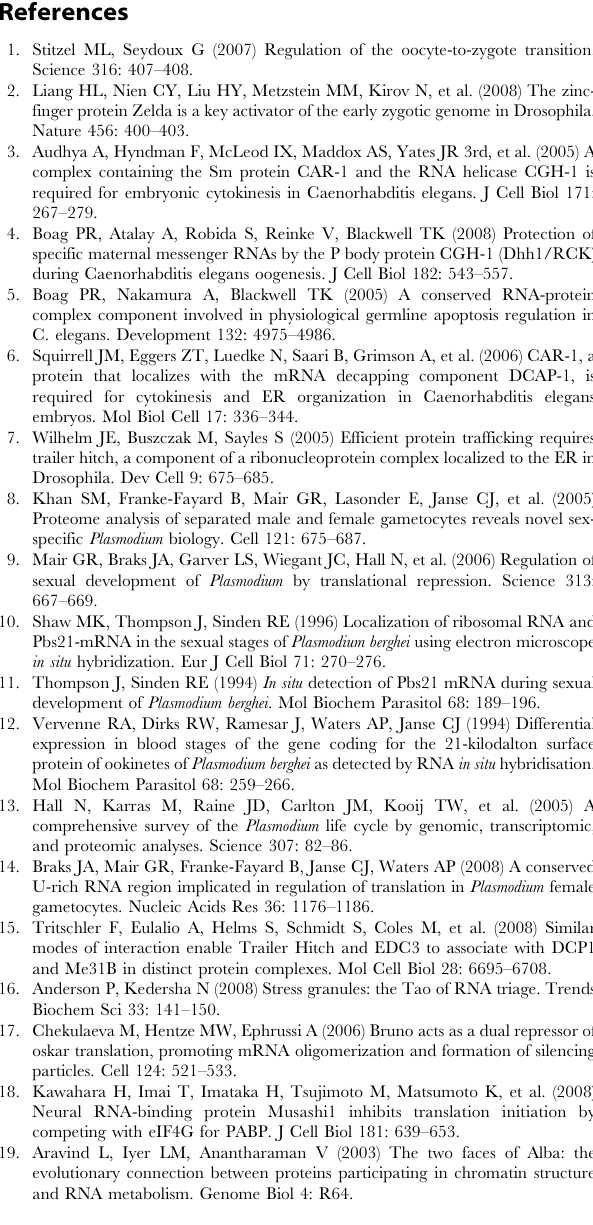
Table S2 Microarray analysis of genes differentially regulated in the CITH-KO Found at: doi:10.1371/journal.ppat.1000767.s018 (0.05 MB XLS) Table S3 Microarray analysis of genes differentially regulated in DOZI-KO and CITH-KO Found at: doi:10.1371/journal.ppat.1000767.s019 (0.04 MB XLS) Table S4 Manually curated genes differentially regulated in CITH-KO and/or DOZI-KO gametocytes Found at: doi:10.1371/journal.ppat.1000767.s020 (0.03 MB XLS) Table S5 The Plasmodium falciparum and P. berghei complement of proteins involved in RNA degradation Found at: doi:10.1371/journal.ppat.1000767.s021 (0.04 MB XLS) Table S6 Oligonucleotide primer list Found at: doi:10.1371/journal.ppat.1000767.s022 (0.02 MB XLS)